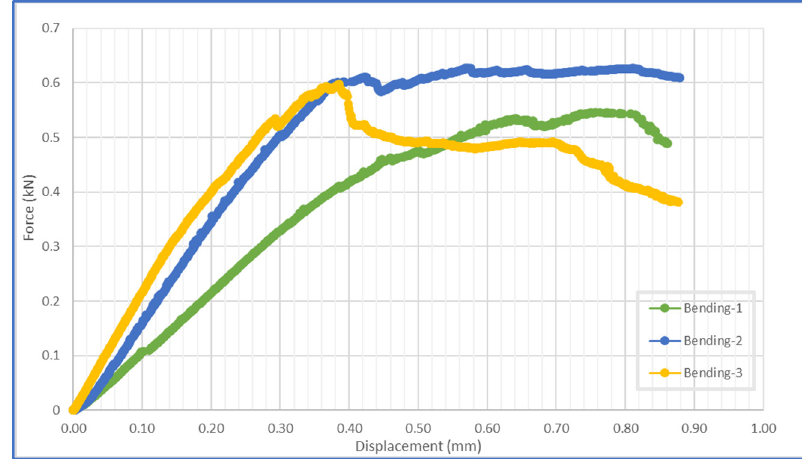
Figure 13. Force–displacement evolution for the bending tests.